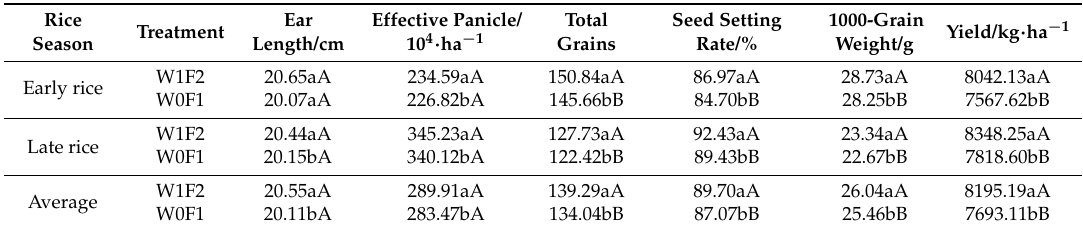
Table 3. Effect of rice paddy water-fertilizer comprehensive regulation technique on